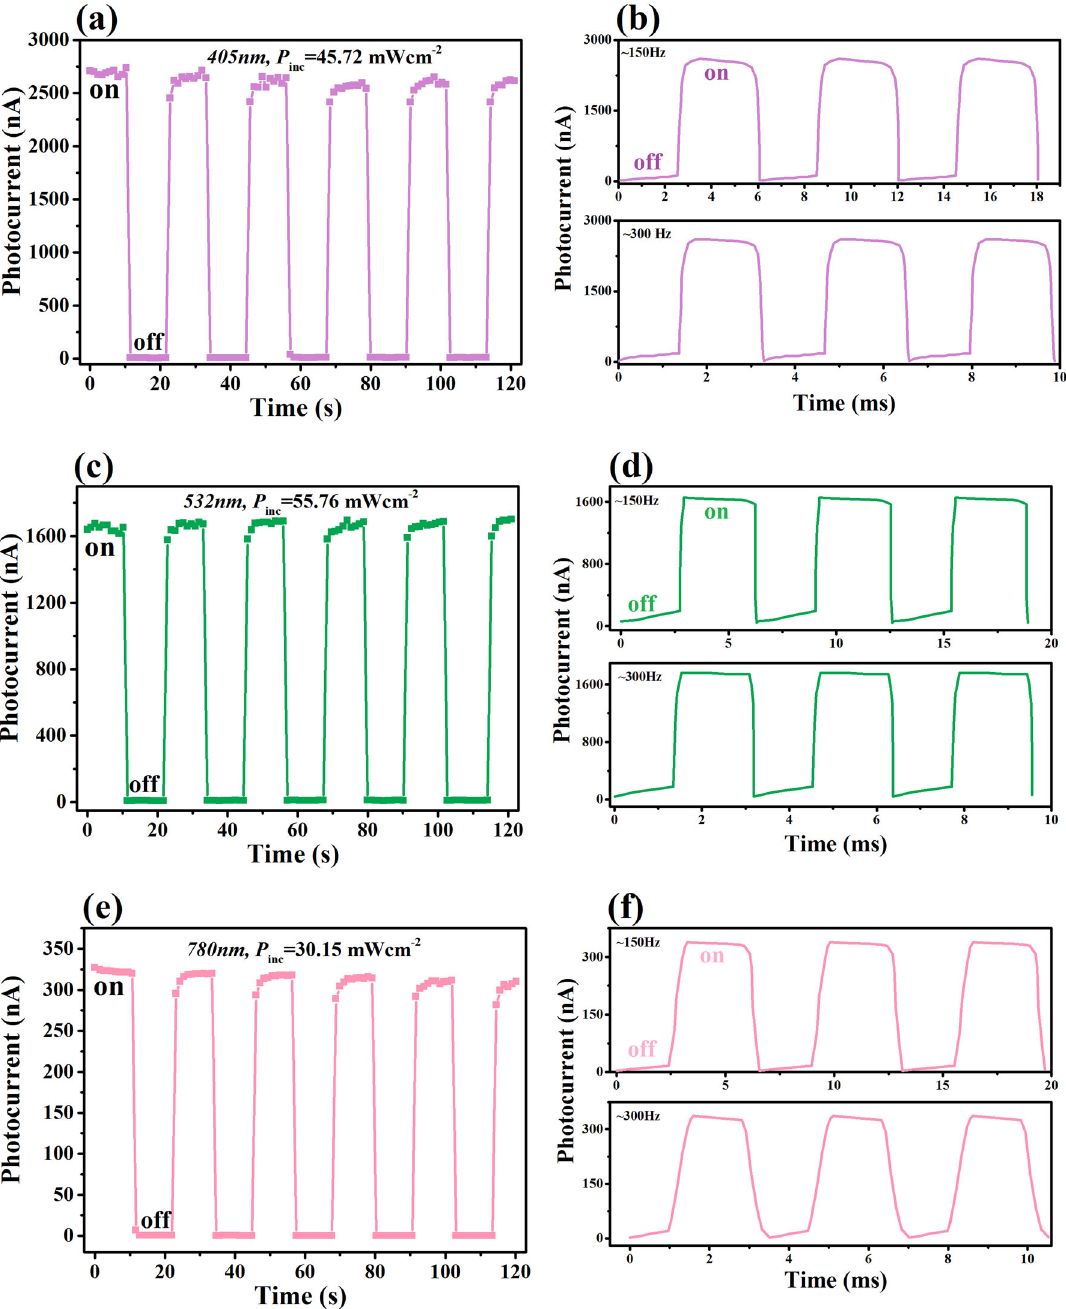
Fig. 4 Time-dependent photocurrent of perovskite-PbPc photodetectors at different wavelengths and photo-switching frequencies with a constant light power and voltage ( V = − 50 V). a , b , c , d and e , f are corresponding to Near-UV illumination of 405 nm, visual illumination of 532 nm and NIR illumination of 780 nm,